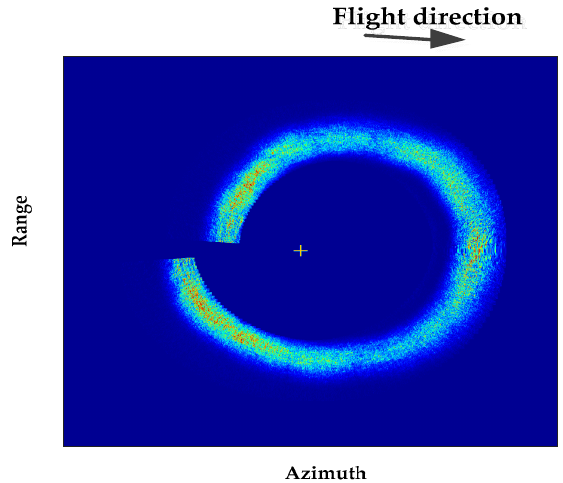
Figure 6. SAR image of the antenna rotating a circuit.